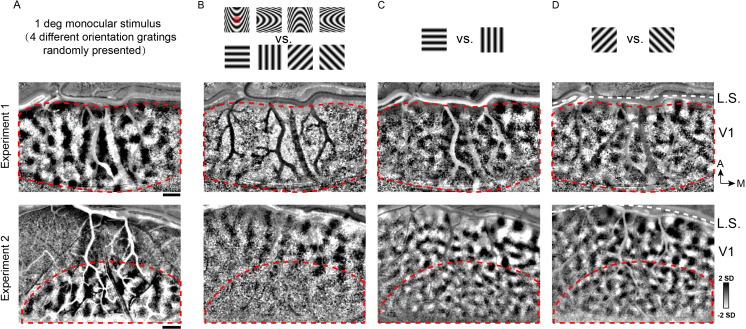
Curvature domains were not observed in V1.Field of view over V1. (A) Ocular dominance columns acquired by presenting monocular oriented stimuli one degree in size (by summing responses across four orientations). Red dashed line: activated V1 region. (B) Cortical response comparison between curved and straight stimuli (stimulus size: four degrees, from the same experiment session). These stimuli shared the same center locations as shown in A. Within the central 1 deg region (within red dashed line, corresponding to location of central red square), there was no obvious preference or response pattern for curvature over straight. Differences only appeared in response to the flanks of the stimulus (outside the red dotted line), perhaps due to different spatial frequencies between flanking regions of the straight and curvature stimuli. (C, D) Orientation maps acquired with the straight stimuli in B. White dotted lines: lunate sulcus (L.S.).